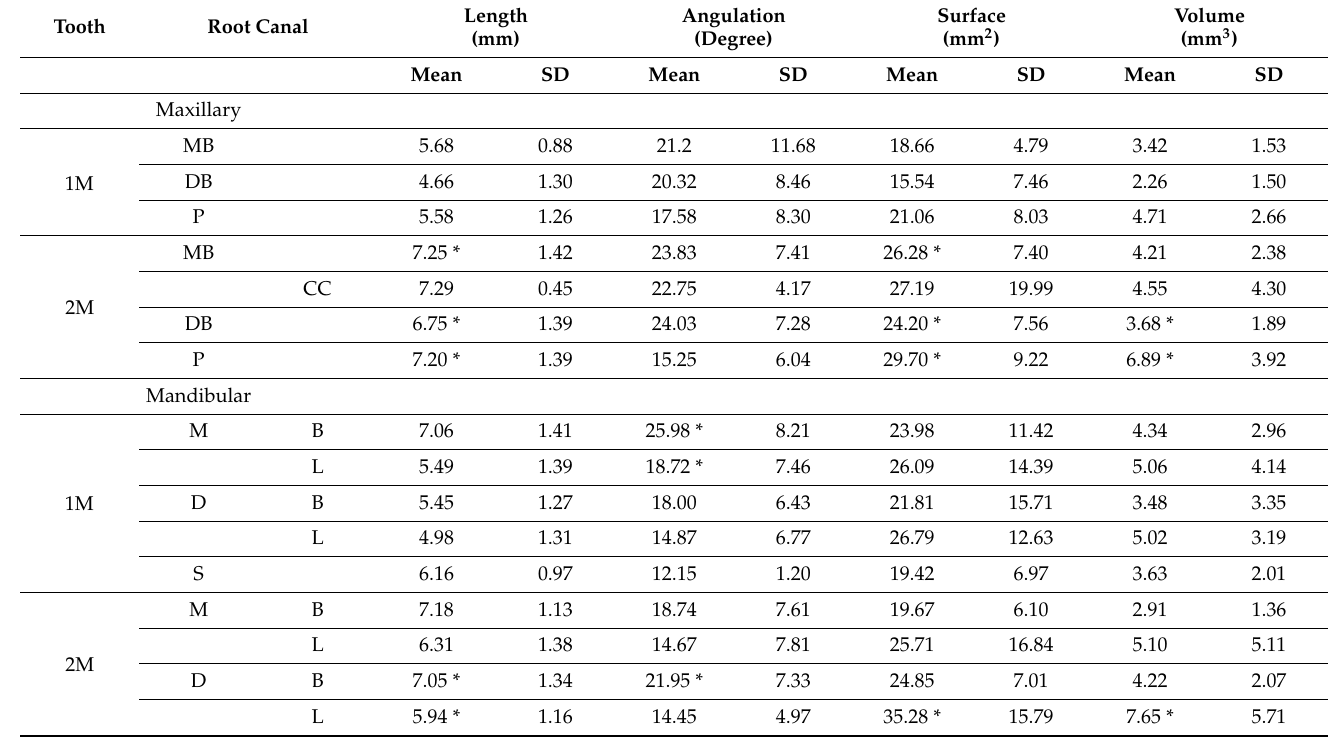
Table 3. Specific characteristics of root